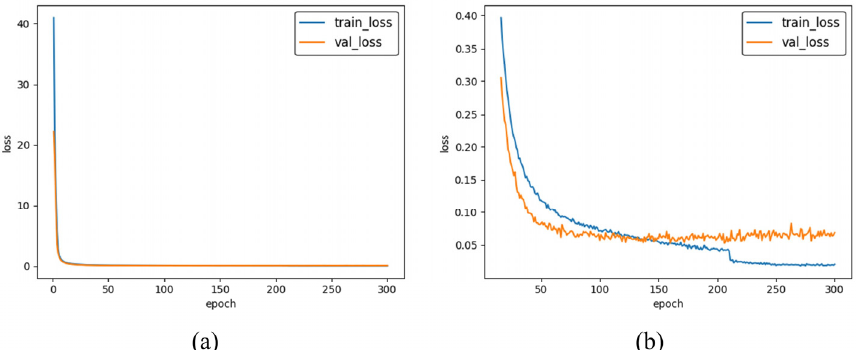
Figure 8. Curve of loss value change during training. ( a ) Loss value curve of 300 epoch training